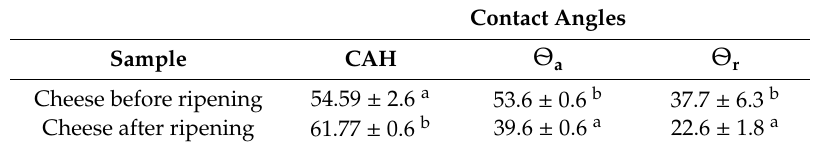
Table 3. Advancing (Ѳ a ) and receding (Ѳ r ) contact angles measured for the cheese samples.